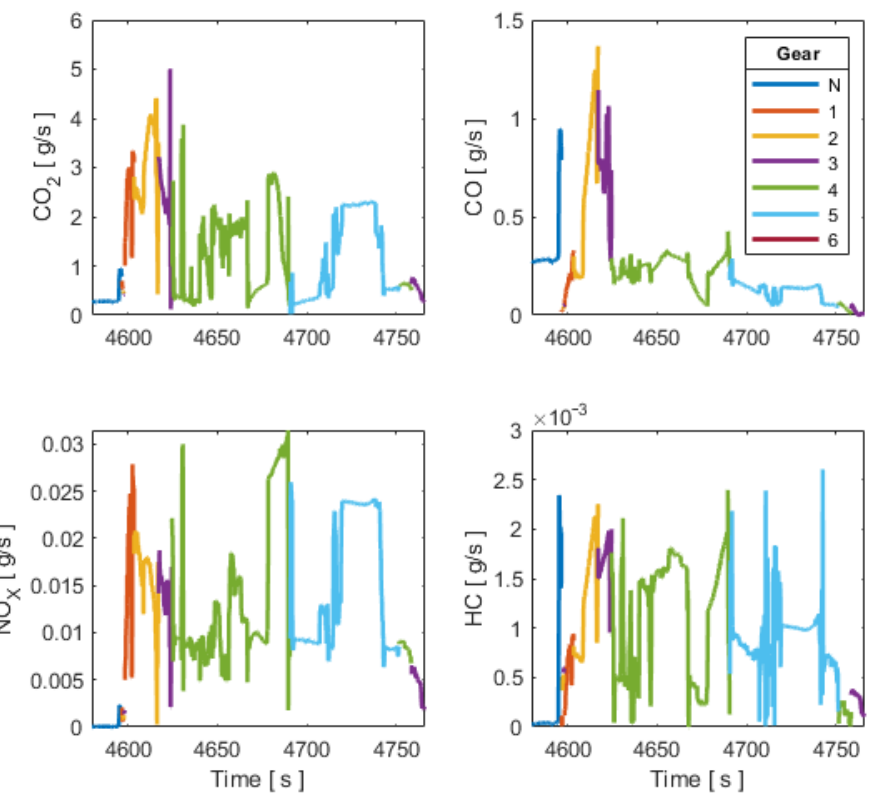
Figure 5. Tailpipe CO 2 , CO, HC and NOX emissions.